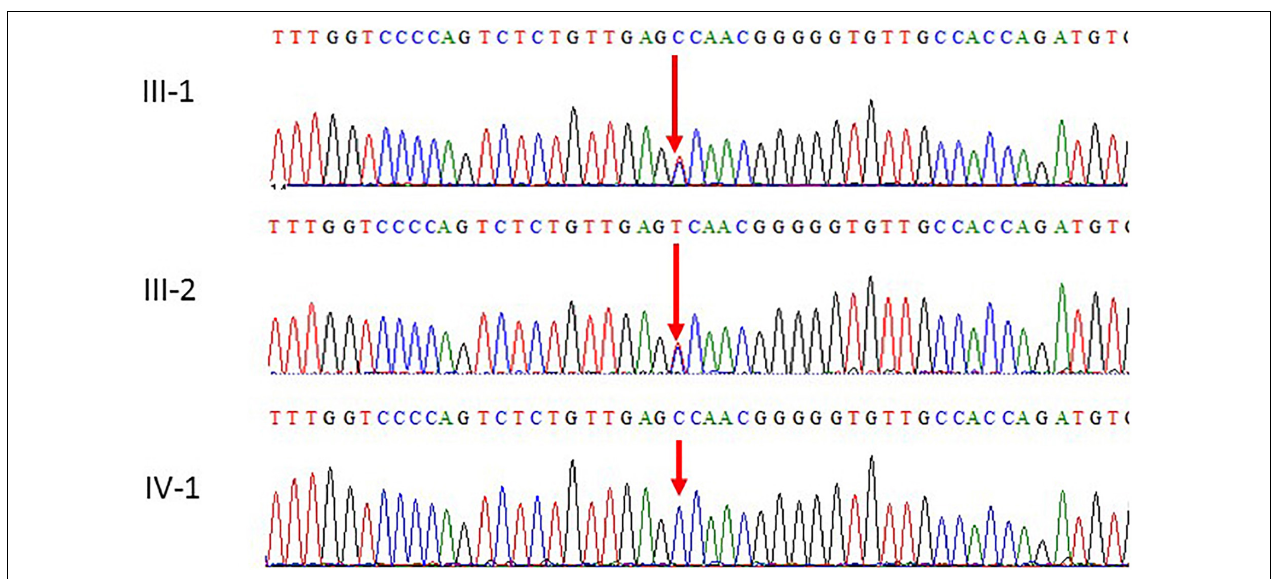
FIGURE 3 | Chromatogram of Sanger sequence analysis III-1 and I-2 are the normal parents, while IV-1 are the affected member of the family showing a novel homozygous missense c.934T > C (p. S312P) of POLR1C